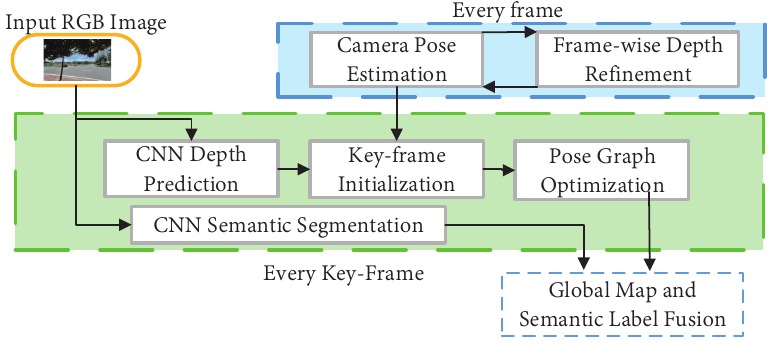
Figure 14. The structure of